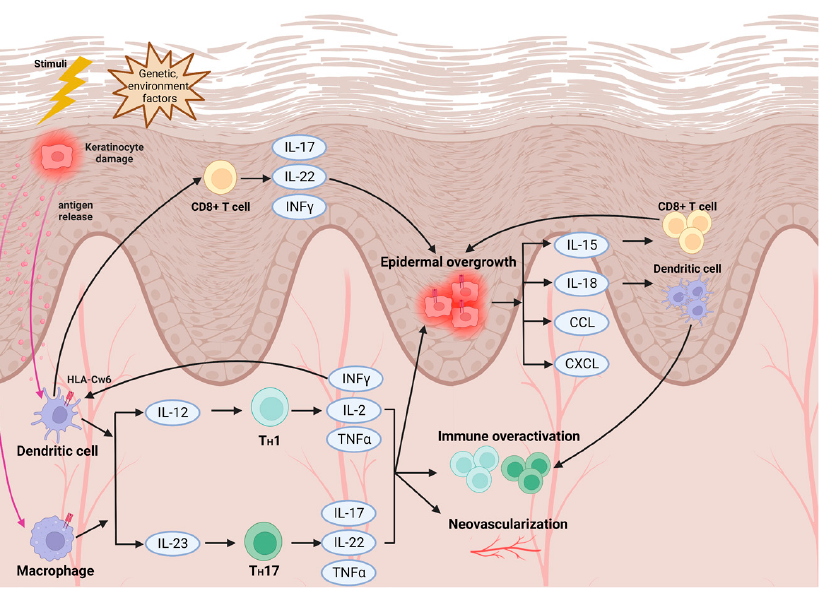
Figure 1. Immunopathogenesis of psoriasis.